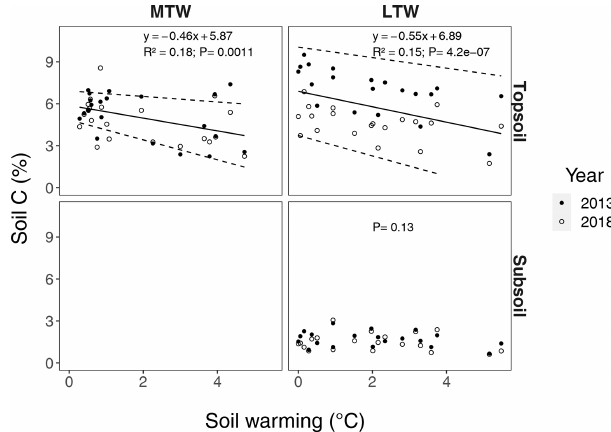
Figure B2. Percentage of carbon in topsoil and subsoil, for the long- term warmed (LTW) and medium-term warmed (MTW) grassland. The 95% confidence bounds are shown around the topsoil linear re- gression slopes. For topsoil, the marginal R 2 from the linear mixed- effects model is shown. (For topsoil, n = 42 and n = 40 for MTW and LTW grassland respectively; for subsoil, n = 40 for LTW grass-